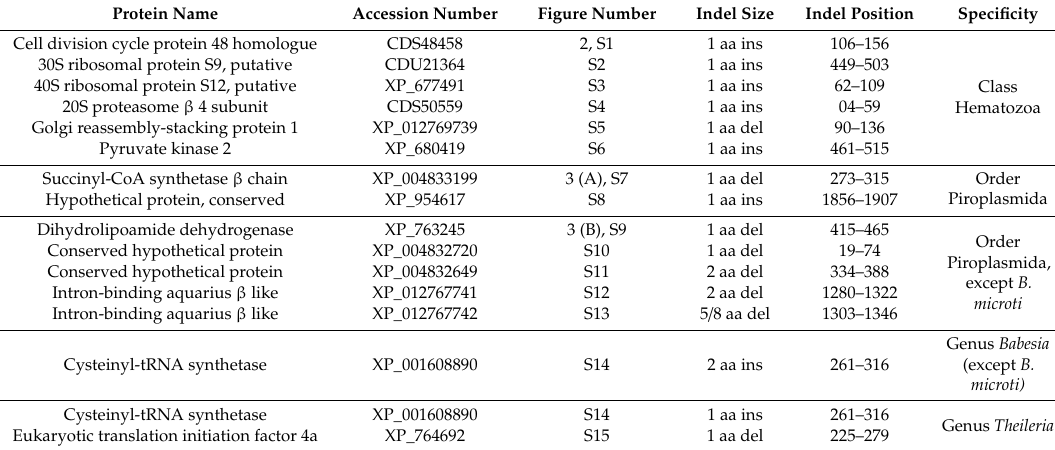
Table 1. Summary of CSIs specific for the class Hematozoa and order